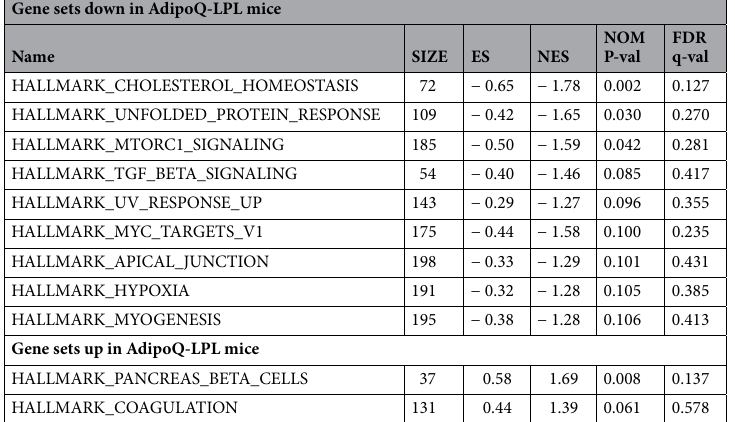
Table 2. Enrichment of hallmark gene sets in adipose tissue. The microarray data for adipose tissue gene expression was analyzed by GSEA to evaluate hallmark gene sets downregulated or upregulated in AdipoQ- LPL mice. The name of the pathway, number of genes (SIZE), Enrichment and normalized enrichment scores, Nominal P values and false discovery rate q-values generated by GSEA are